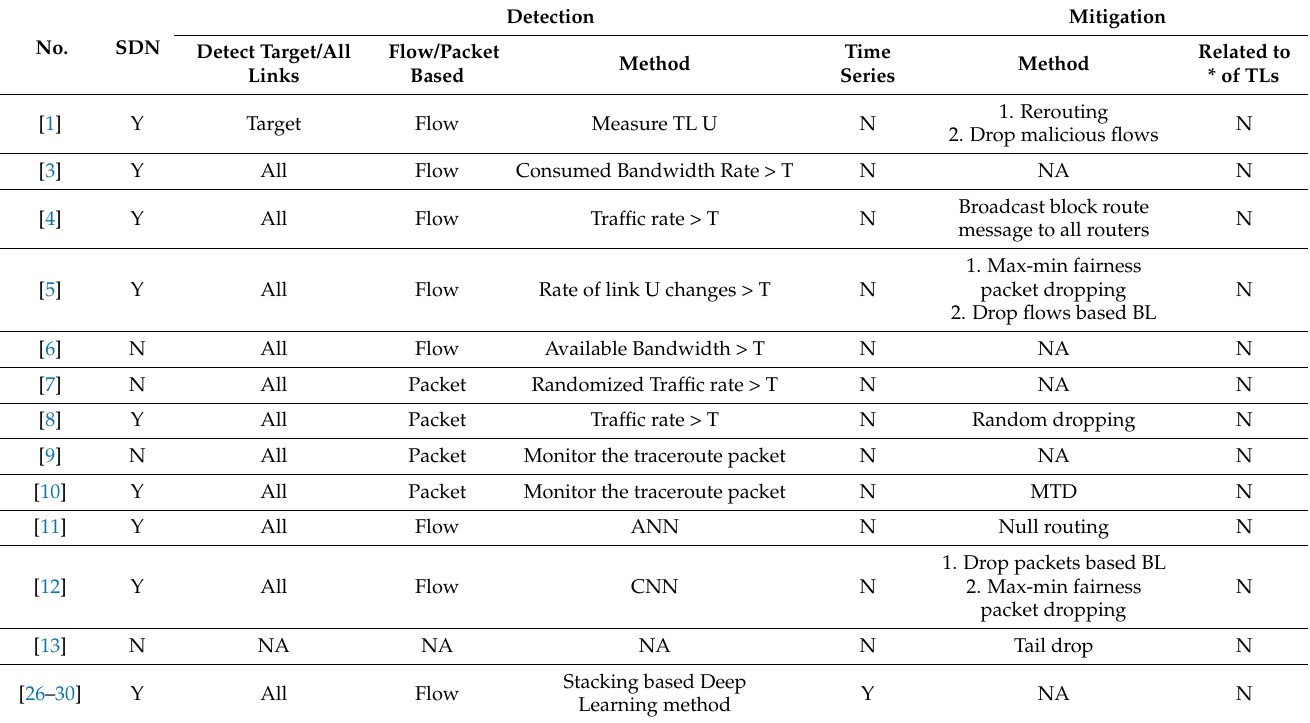
Table 1. LFA detection and mitigation comparison